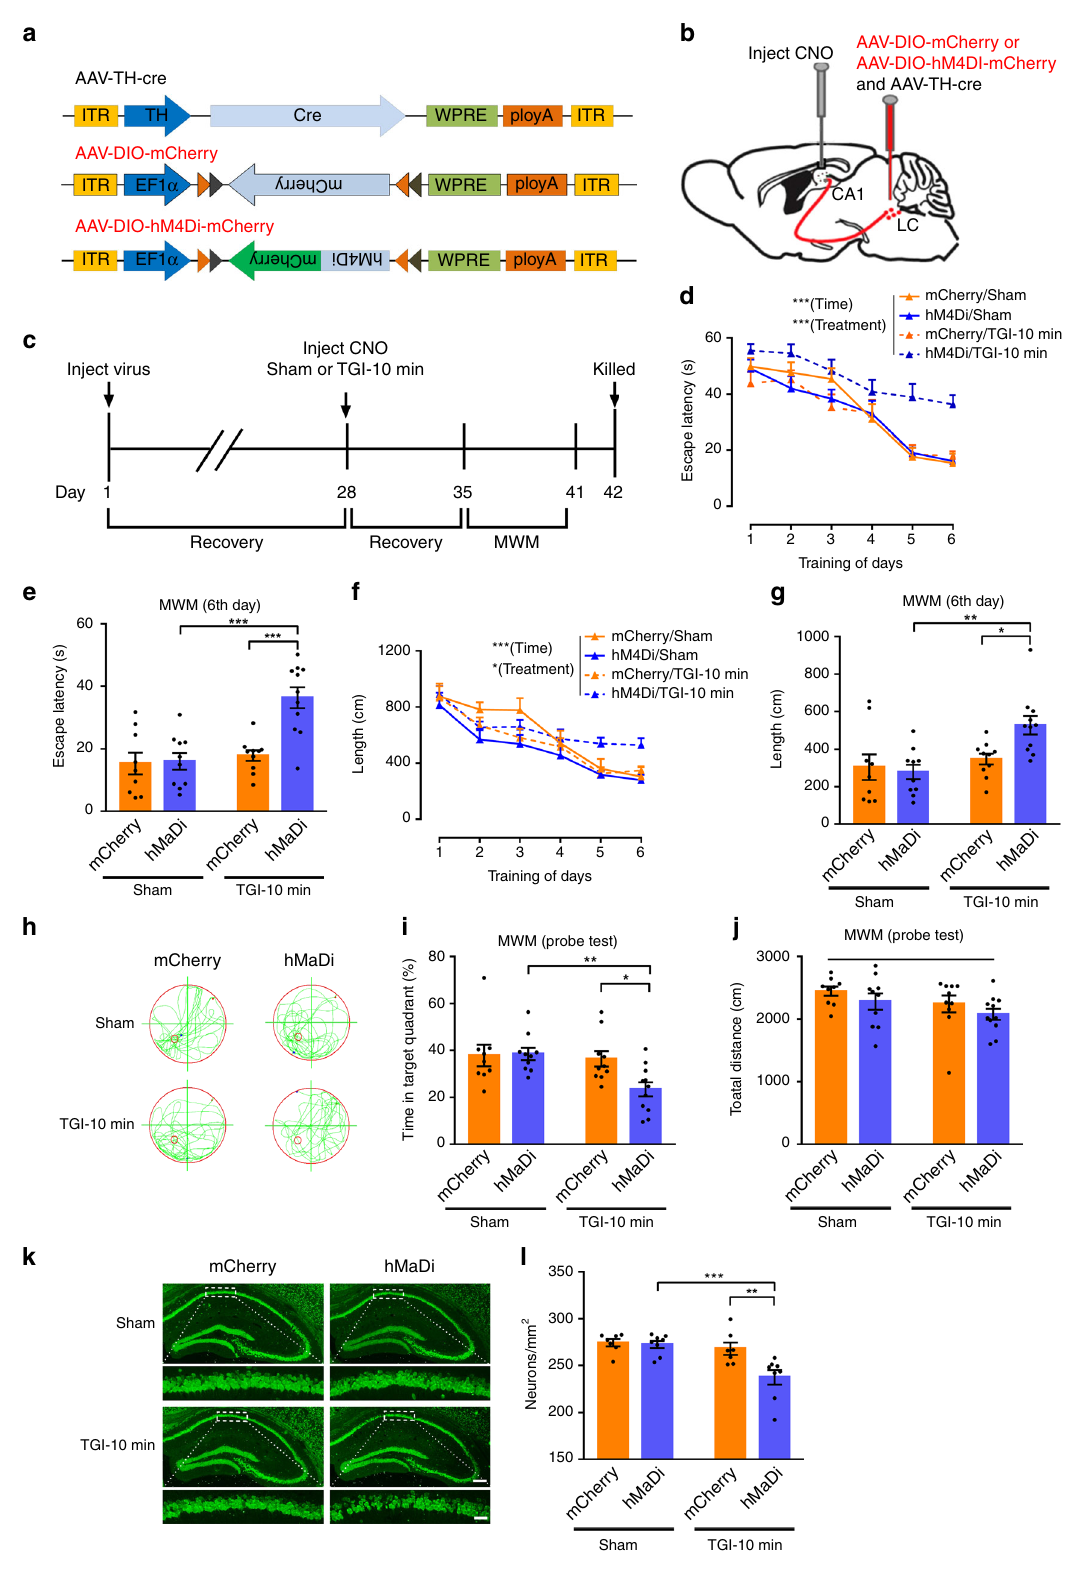
Dopamine neurotransmission in the dorsal hippocampus is crucial for spatial learning and memory 52,53 . Earlier studies have suggested that the TH + neuron population of the VTA is the presumed source of dopamine in the dorsal hippocampus 53 – 55